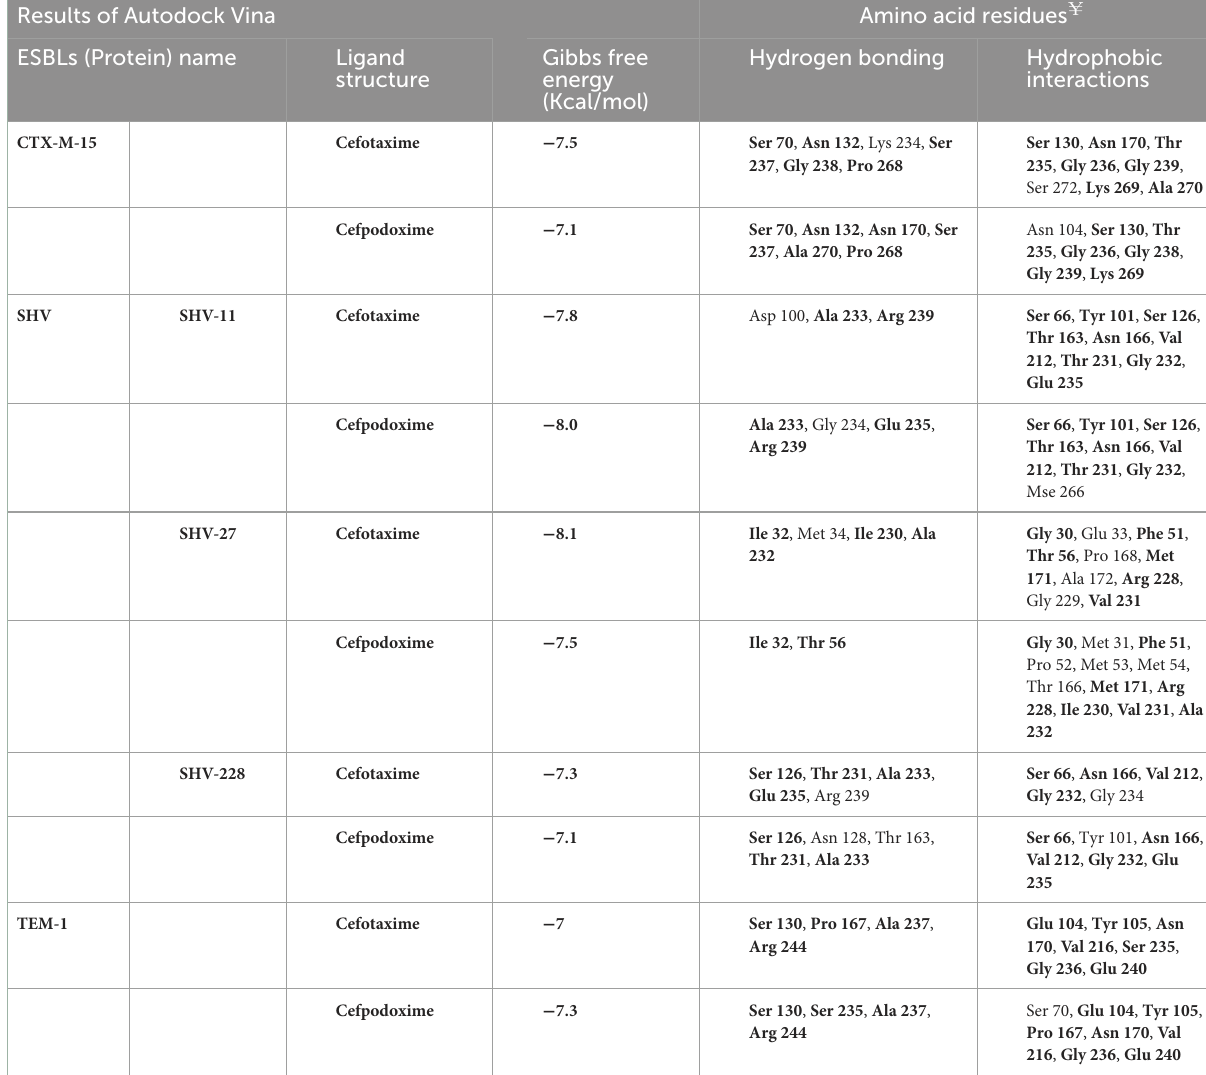
TABLE 4 Summary of in silico